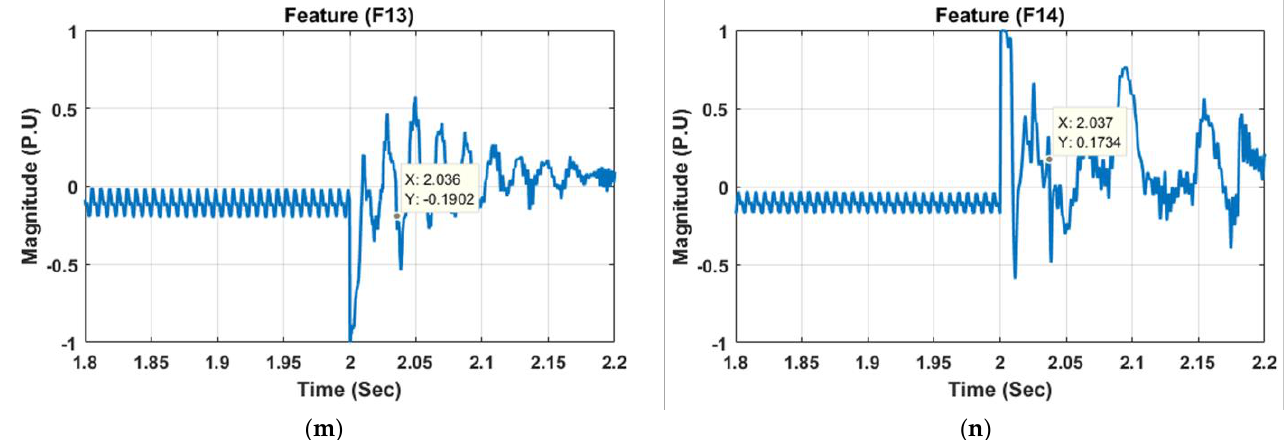
Figure 3. Sample features for a positive line-to-ground fault at 10% of the transmission line with fault resistance of 0.02 ohm. ( a ) Feature F1, ( b ) Feature F2, ( c ) Feature F3, ( d ) Feature F4, ( e ) Feature F5, ( f ) Feature F6, ( g ) Feature F7, ( h ) Feature F8, ( i ) Feature F9, ( j ) Feature F10, ( k ) Feature F11, ( l ) Feature F12, ( m ) Feature F13, ( n ) Feature F14. Table 2. Features at R1 for a positive pole-to-ground fault at 50% of Line-1.